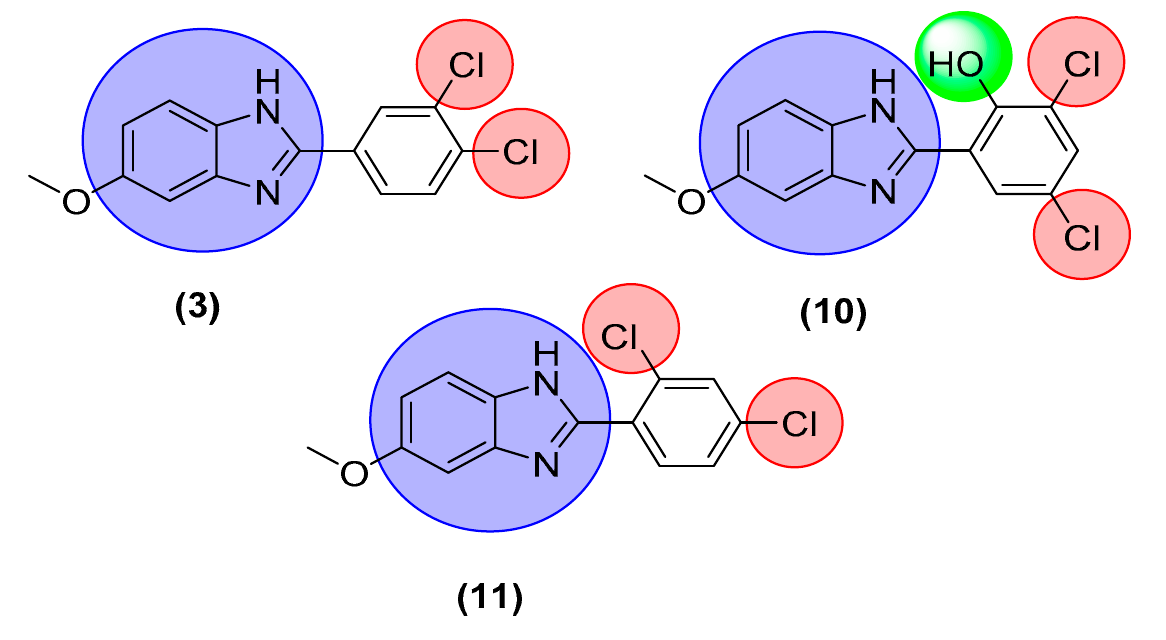
Figure 7. SAR studies of compounds 3 , 10, and 11 . Scaffolds 15 and 16 both have hydroxyl groups, but their positions are different. In compound 15 the hydroxyl group is at the para position, and it has IC 50 values of 0.80 ± 0.001 and 0.90 ± 0.001 for AChE and BuChE, respectively. While for analog 16 , the hydroxyl group is at the meta position, and the IC 50 values of this compound are 1.30 ± 0.10 and 2.10 ± 0.10 for AChE and BuChE, respectively (Figure 8). This shows that